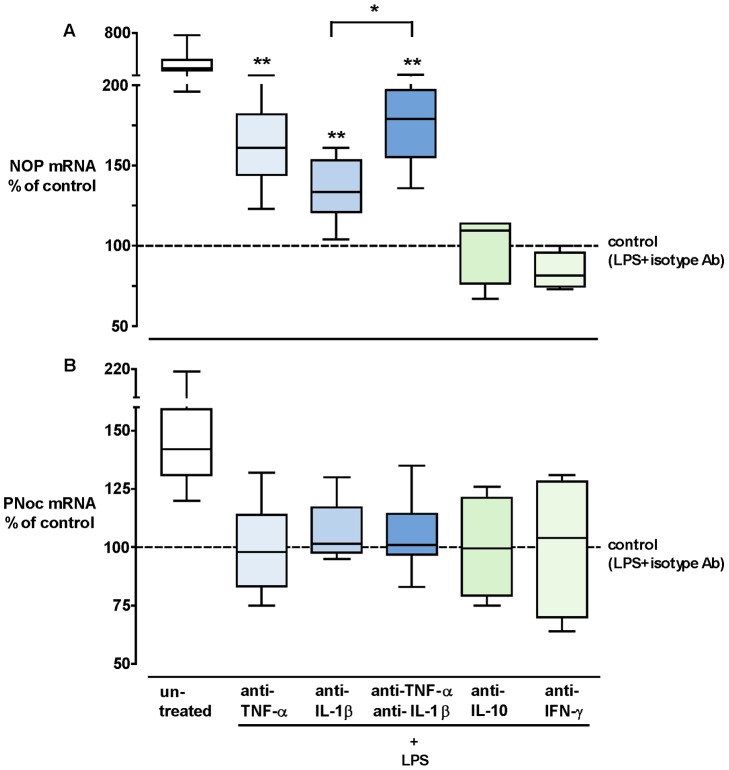
Intervention study.Percent change of NOP (A) and PNoc (B) mRNA expression in whole blood cells after incubation with LPS+anti-TNF-α 5 µg/ml, LPS+anti-IL-1β 5 µg/ml, LPS+anti-TNF-α 5 µg/ml+anti-IL-1β 5 µg/ml, LPS+anti-IL-10 5 µg/ml, LPS+anti-IFN-γ 5 µg/ml, LPS+isotype control 5 µg/ml (dashed line set to 100%) or without any treatment (untreated) for 3 hrs. Box plots show medians (horizontal lines), interquartile ranges (boxes) and 5th/95th percentiles (error bars). n = 10, Mann-Whitney U test, *: p<0.01, **: p<0.001, corrected for multiple testing. LPS, lipopolysaccharide; NOP, nociceptin receptor; PNoc, nociceptin precursor; TNF, tumor necrosis factor; IL, interleukin; IFN, interferon.xl.